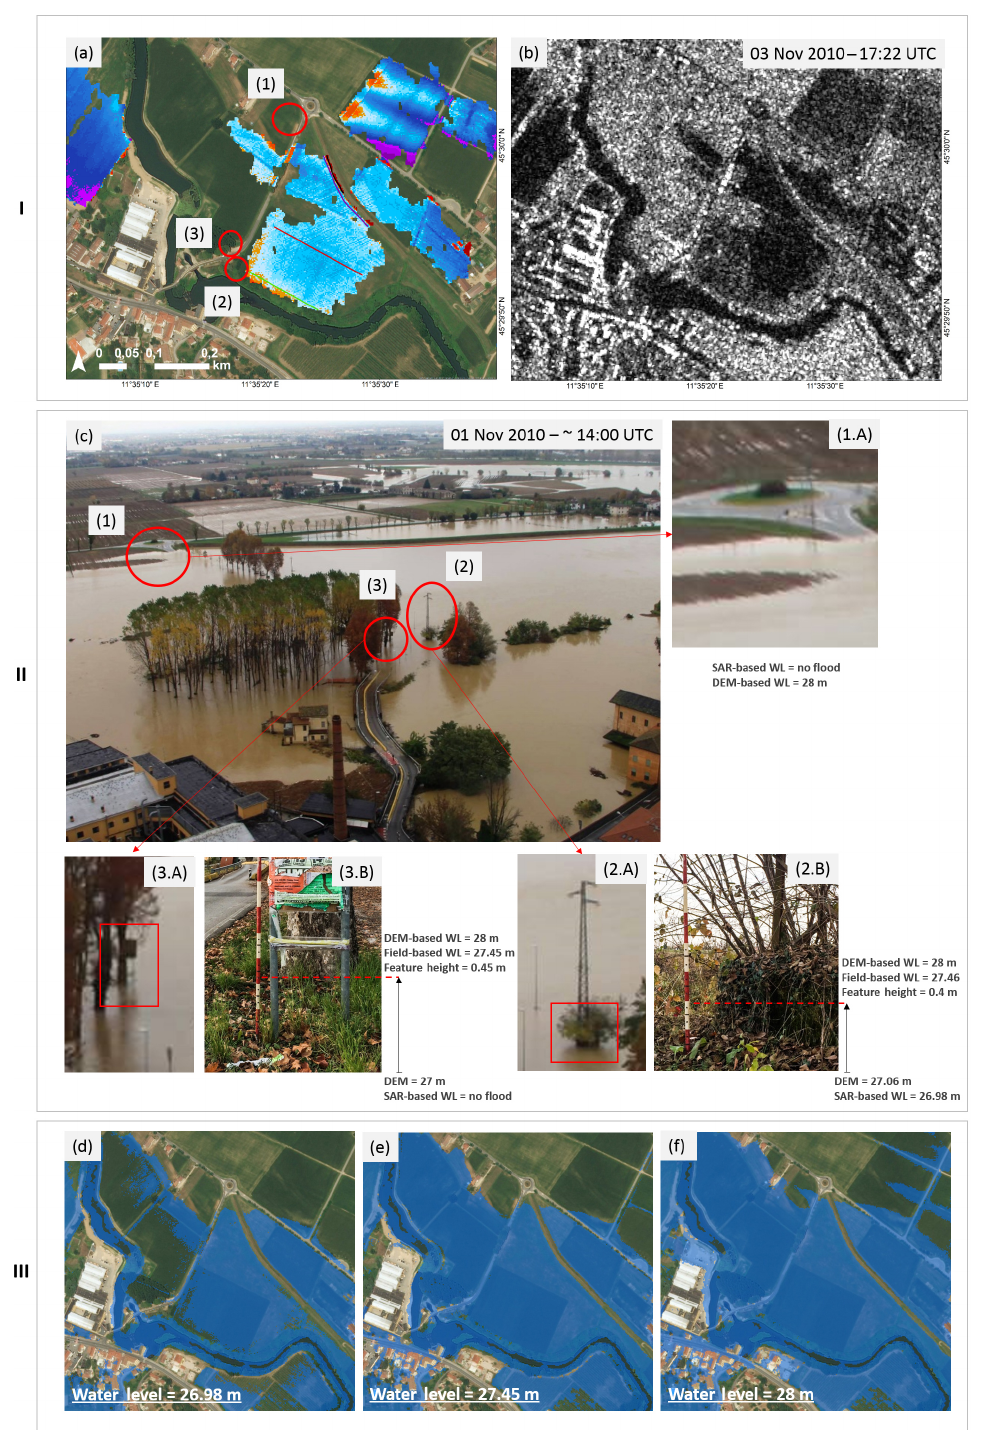
Figure 10. Flood depth on 3 November over Ponti di Debba in the Vicenza area of interest; panel I shows (a) flood depth in the area analyzed; (b) CSK image acquired on 3 November at 17:22UTC from where the flood map has been derived; panel II shows (c) an aerial view of the event acquired on 1 November at about 14:00UTC with zooms on three areas (1.A, 2.A, 3.A) with relative fieldwork images (2.B and 3.B); panel III shows the flood extent derived with the DEM-fill method for different water levels: (d) with a water level equal to 26.98m corresponding to the level estimated by the proposed method; (e) with a water level equal to 27.45m corresponding to the water level estimated by fieldwork data; (f) with a water level equal to 28m corresponding to the level estimated by the DEM-fill method in order to obtain the same flood extent of the aerial